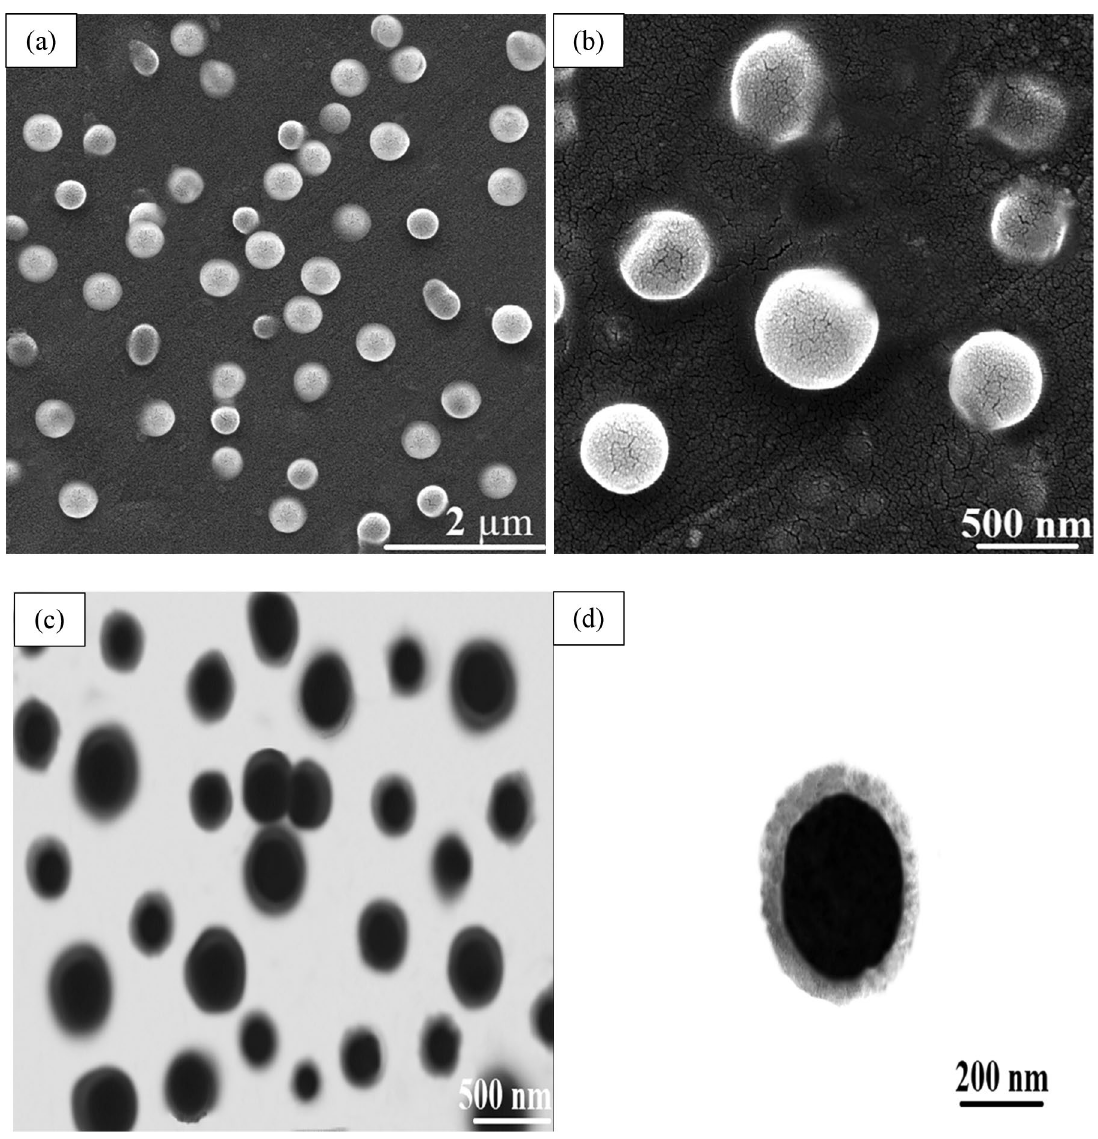
Figure 2. SEM ( a , b ) and TEM ( c , d ) images of the prepared